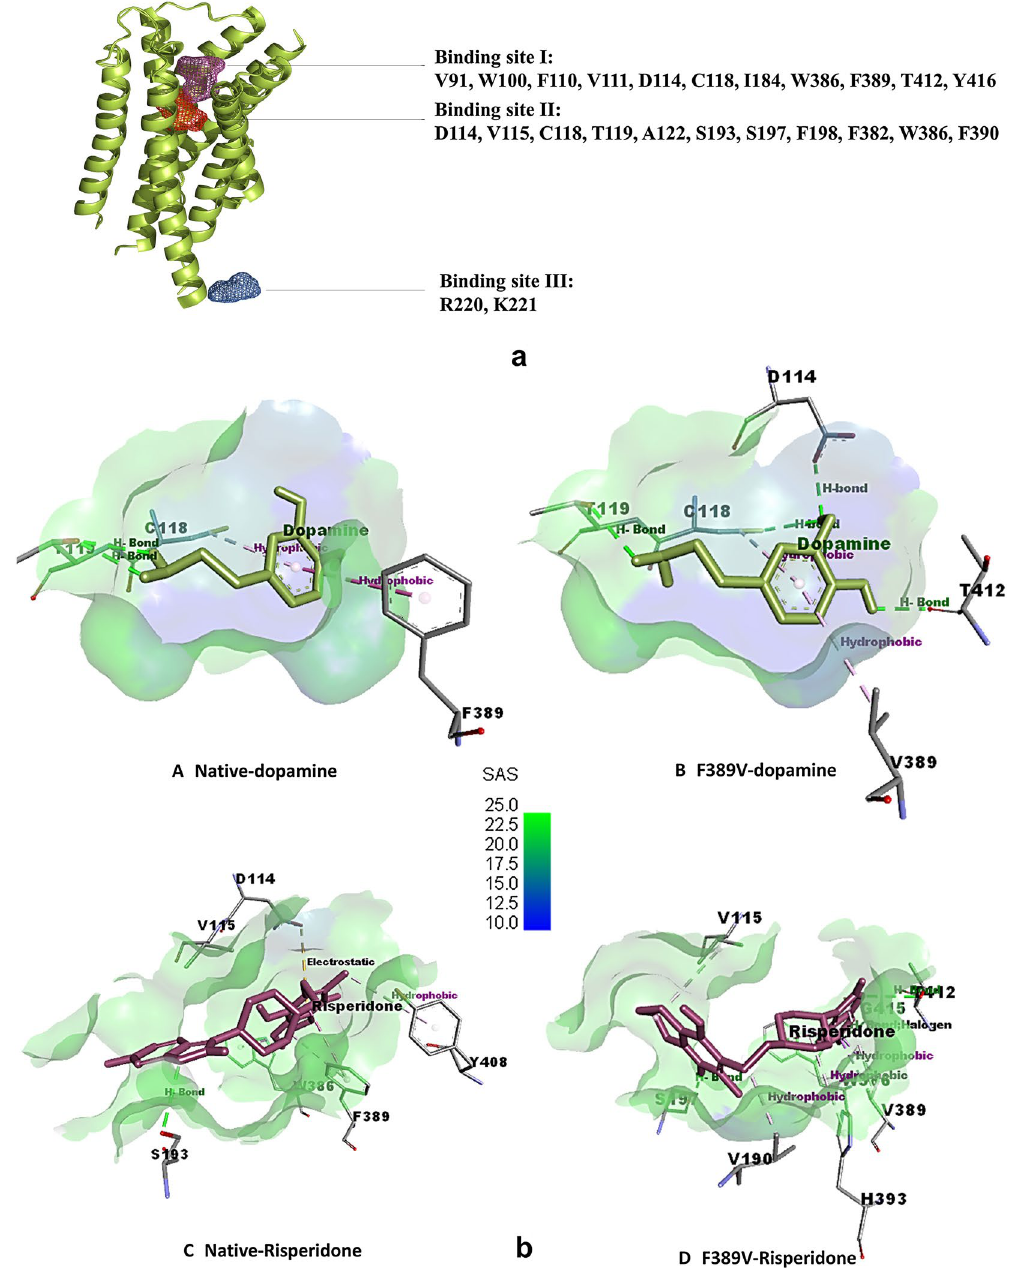
Figure 6. Binding site prediction and visualization of the molecular docking output. ( a ) FTSite predicted three ligand binding sites in DRD2. ( b ) Ligand non-bond binding interactions between the protein residues and the ligands visualized by Discovery Studio. Dopamine docked against (I) native DRD2 (II) F389V mutant; and risperidone docked against (III) native DRD2 and (IV) F389V mutant are presented. The receptor surface is colored according to solvent accessibility surface (SAS) in an ascending degree from blue to